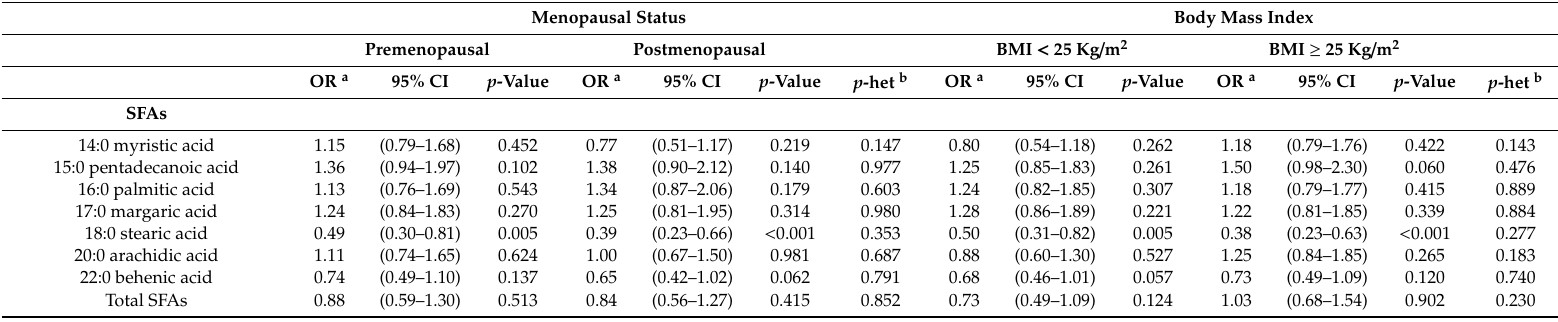
Table 3. Breast cancer risk for the third tertile compared with the first tertile of each serum phospholipid fatty acid by menopausal status and by body mass